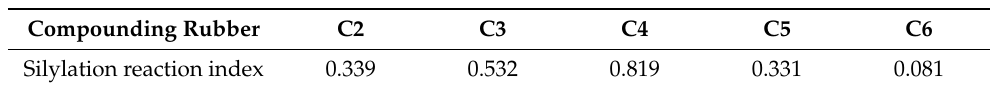
Figure 9. Silylation reaction image. Table 7. Silylation reaction index.